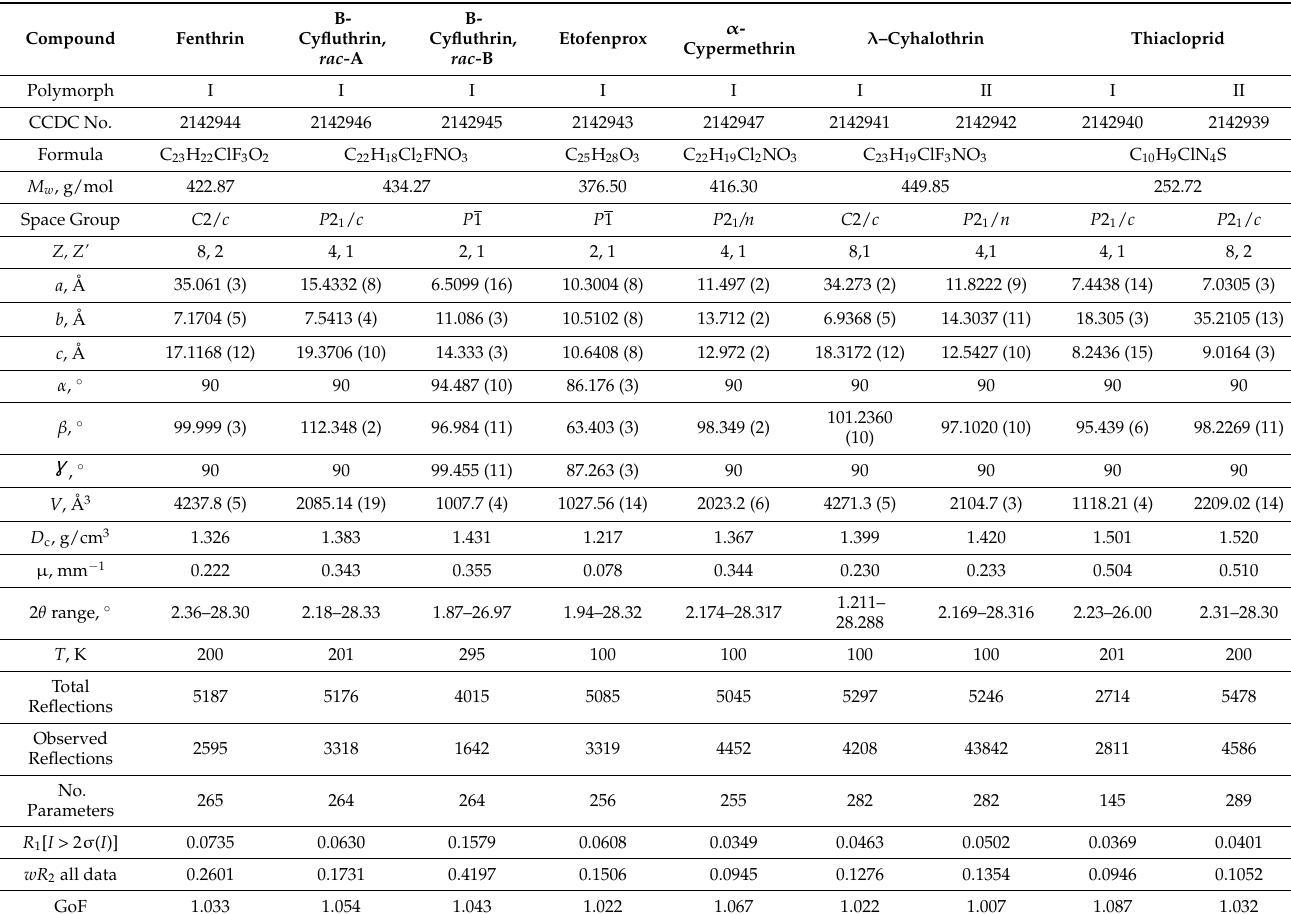
Figure 7. Single-crystal structures of thiacloprid Forms I ( A ) and II ( B ). The unit cell of Form I contains 8 symmetry-related molecules, whereas the unit cell of Form II contains 4 symmetry-related molecules. Table 1. Single-crystal X-ray crystallography data obtained for insecticides, and corresponding experimental conditions.